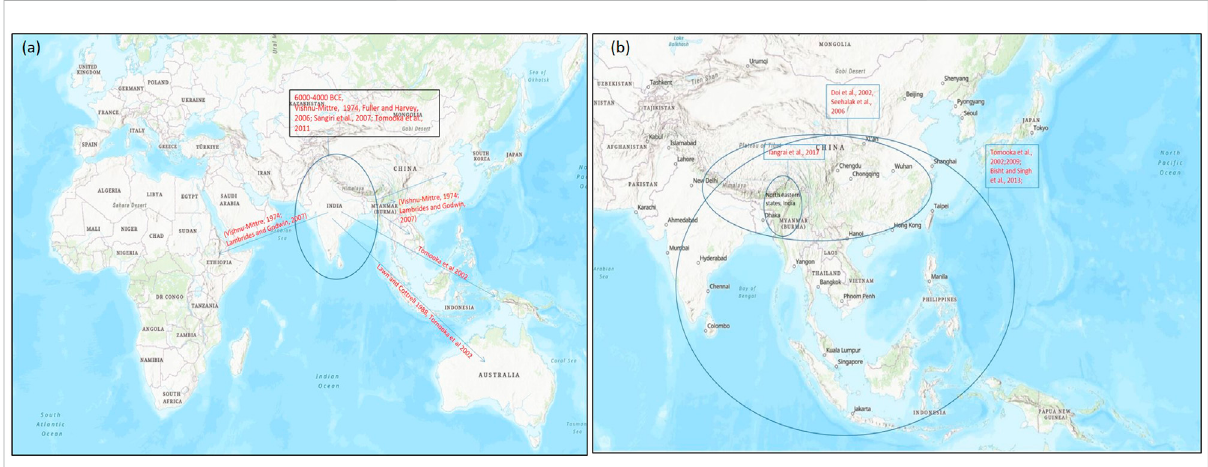
FIGURE 3 Map representing the origin of domestication of (A) mung bean ( Vigna radiata ) and (B) rice bean ( Vigna umbellata ) (encircled) and their spread (arrow) to different parts of the world on the basis of archeological evidences and genetic studies for domestication-related traits. Map source: